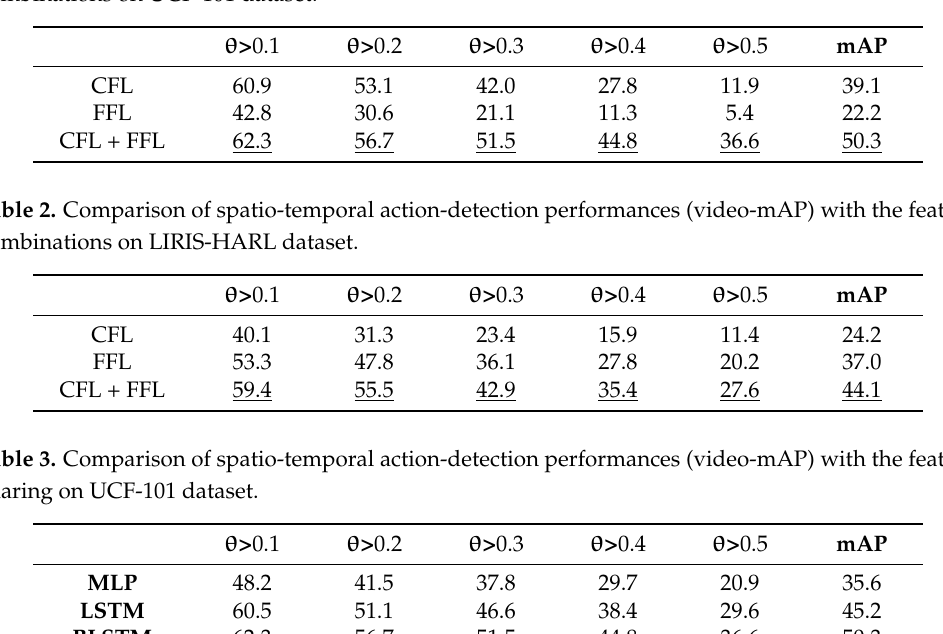
Table 1. Comparison of spatio-temporal action-detection performances (video-mAP) with the feature combinations on UCF-101 dataset.